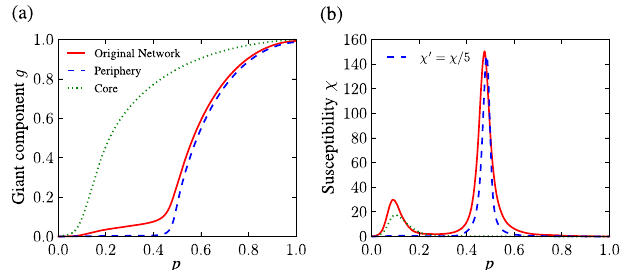
FIG. 4. Bond percolation simulations of the core and periphery of a network with N ¼ 5 × 10 4 , γ ¼ 3 . 1 , and target clustering spectrum ¯ c ð k Þ ¼ 0 . 25 . The bond occupation probability to separate the core is p ¼ 0 . 2 . The susceptibility curve of the periphery (dashed blue line) has been divided by 5 for ease of